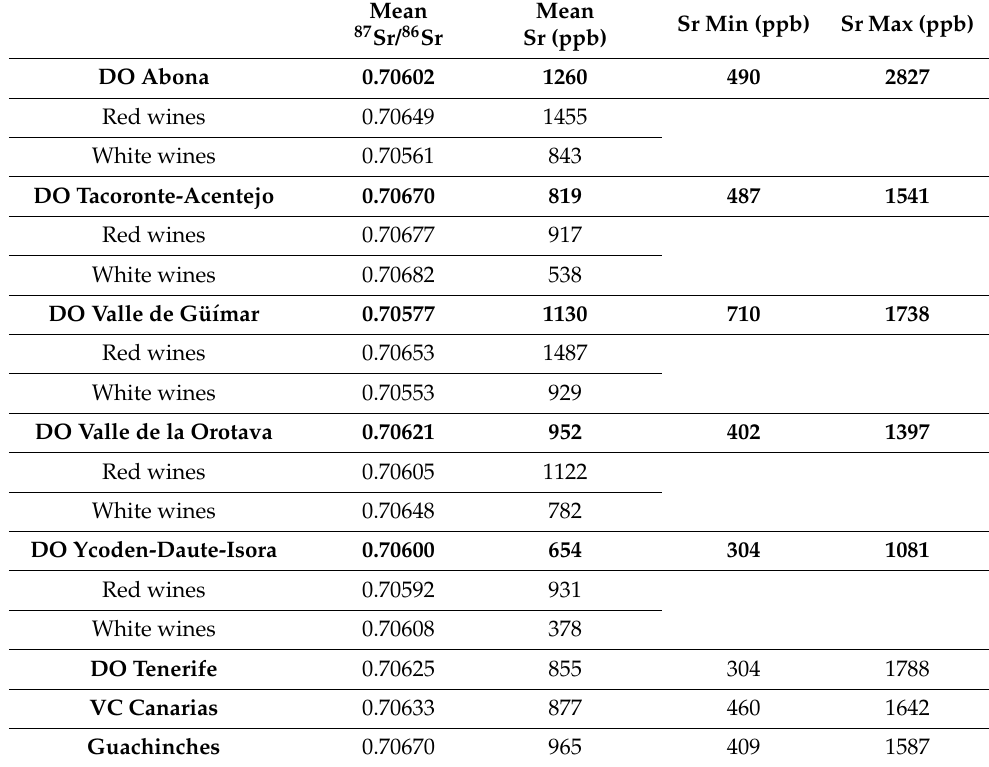
Figure 4. Sr isotope and concentration fields for wines from the five regional Denominación de Origens of Tenerife. Note that the Sr concentration scale varies between DOs. The three samples outside the field indicated in DO Abona are discussed in Section 4.5. Symbols represent wine samples in each DO. Table 3. Mean isotopic and elemental Sr by Denominación de Origen and wine type in Tenerife (individual sample data can be found in Supplementary Material Table S4).